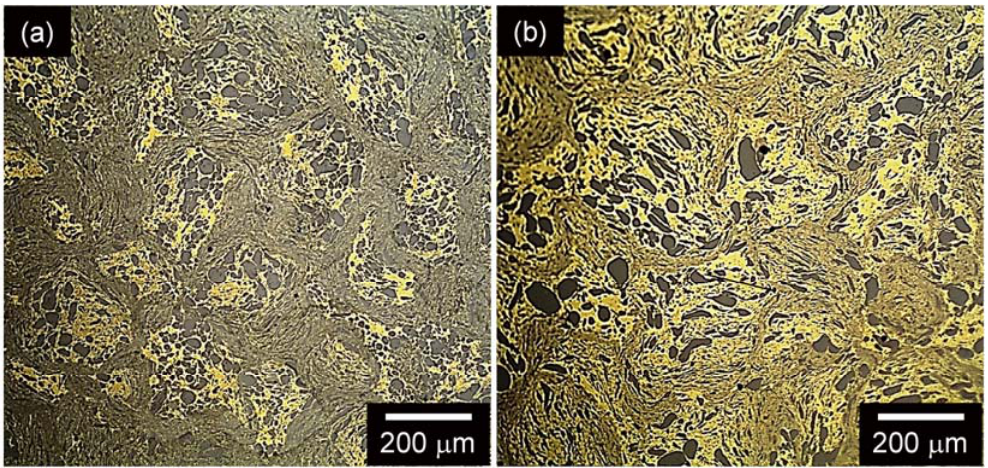
Figure 12. OM micrographs for the consolidated milled composites with ( a ) 40 vol.% and ( b ) 60 vol.% glass